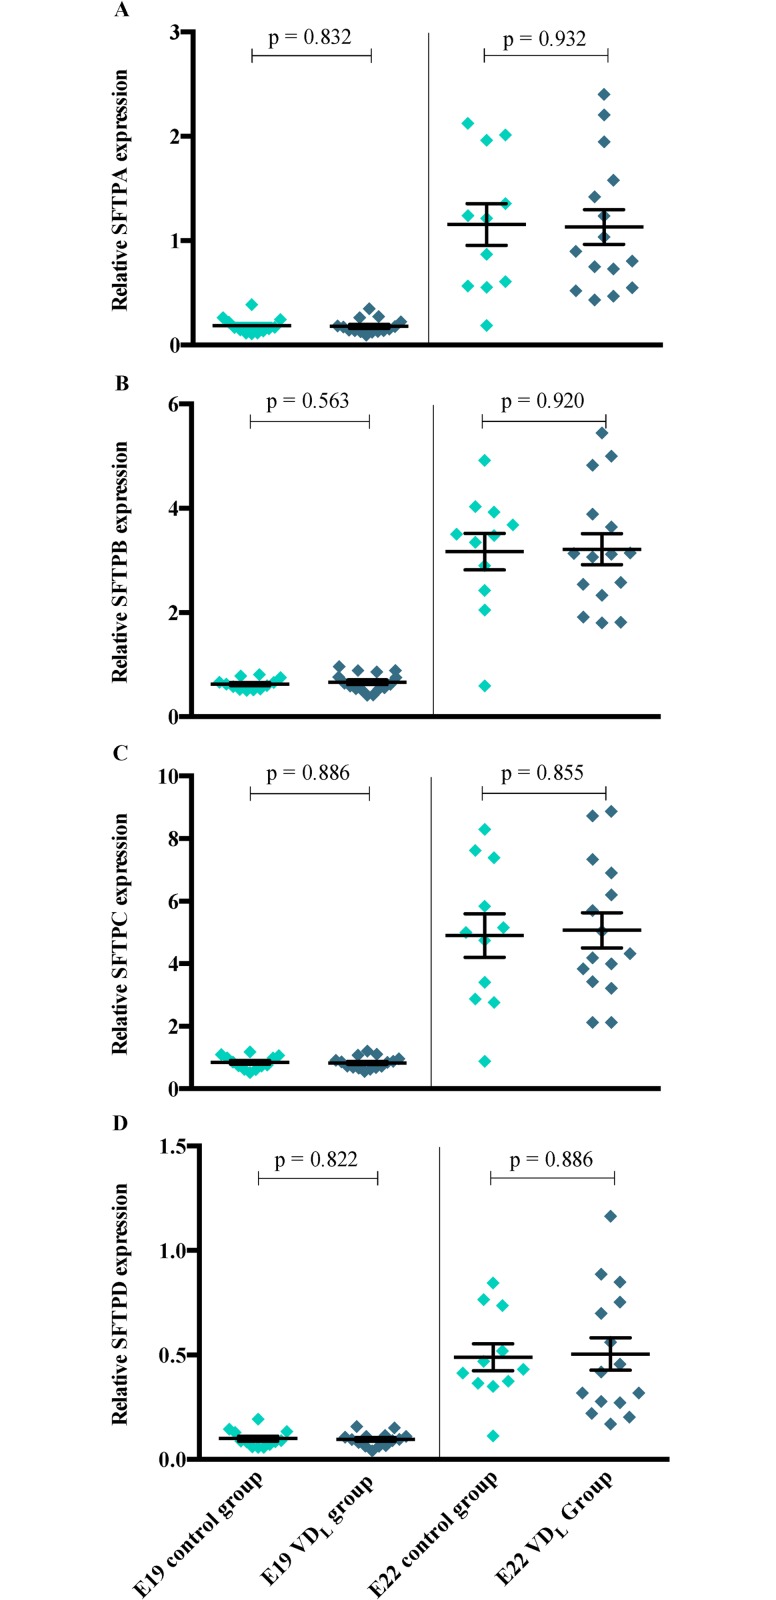
Effects of vitamin D on mRNA levels of surfactant proteins.Quantitative real-time PCR analysis of surfactant protein A-D mRNA transcripts in fetal rat lung at E19, VDL group (n = 15); control group (n = 12) and at E22, VDL group (n = 15); control group (n = 11). Data were normalized against GAPDH. Results were calculated as mean ± SEM values.